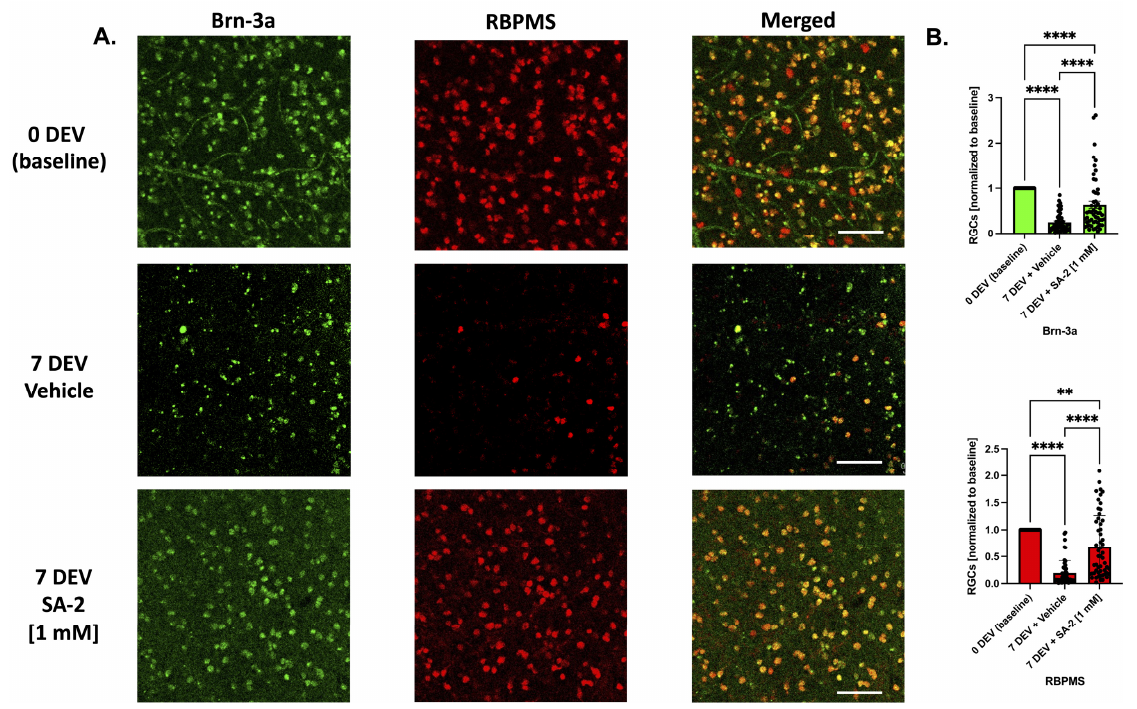
Figure 6. Ex vivo trophic factor deprivation model in human explants. ( A ) Representative images of the human RGCs at 0-day ex vivo (DEV), 7-day ex vivo (7 DEV) with the vehicle (DPBS), and 7 DEV with SA-2 [1 mM]. RGCs were stained with RGC markers Brn-3a (green) and RBPMS (red). The scale bar represents 100 µ m. ( B ) RGC count showed preservation of RGCs treated with SA-2 at 7 DEV compared to the vehicle-treated group in both Brn-3a (156.13% increase, p < 0.0001) and RBPMS staining (249.38%, p < 0.001) using Kruskal–Wallis followed by Dunn’s multiple comparisons. Data represent the mean ± SEM (n = 4 donors/experiments). ** p < 0.01, **** p <